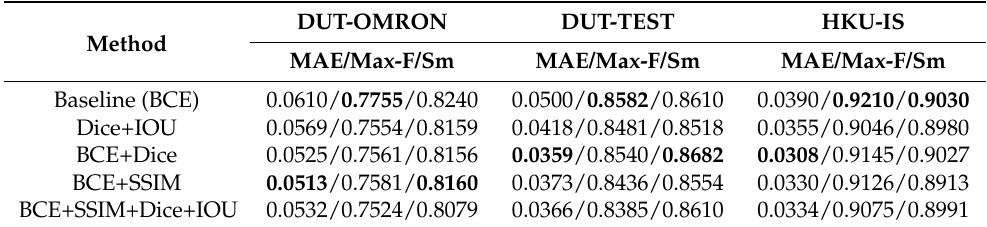
Table 3. Comparison of different combinations of loss functions. The summation of loss functions is without extra parameters. The bold number indicate the best